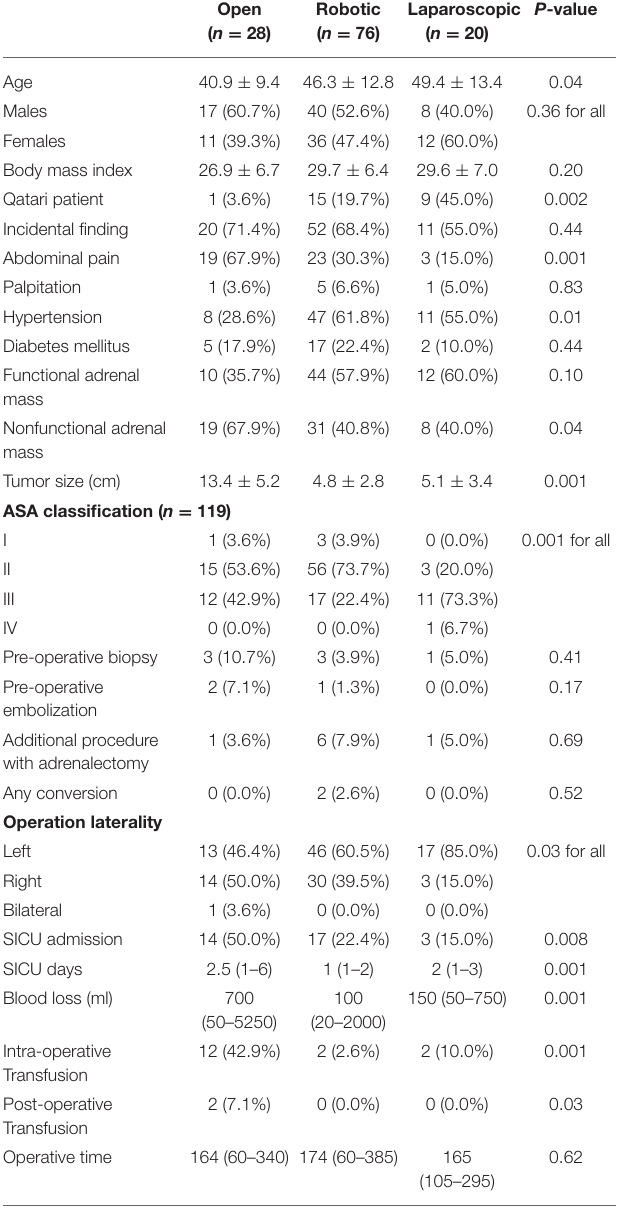
TABLE 2 | Demographics, clinical presentation, and hospital course based on the surgical approach.